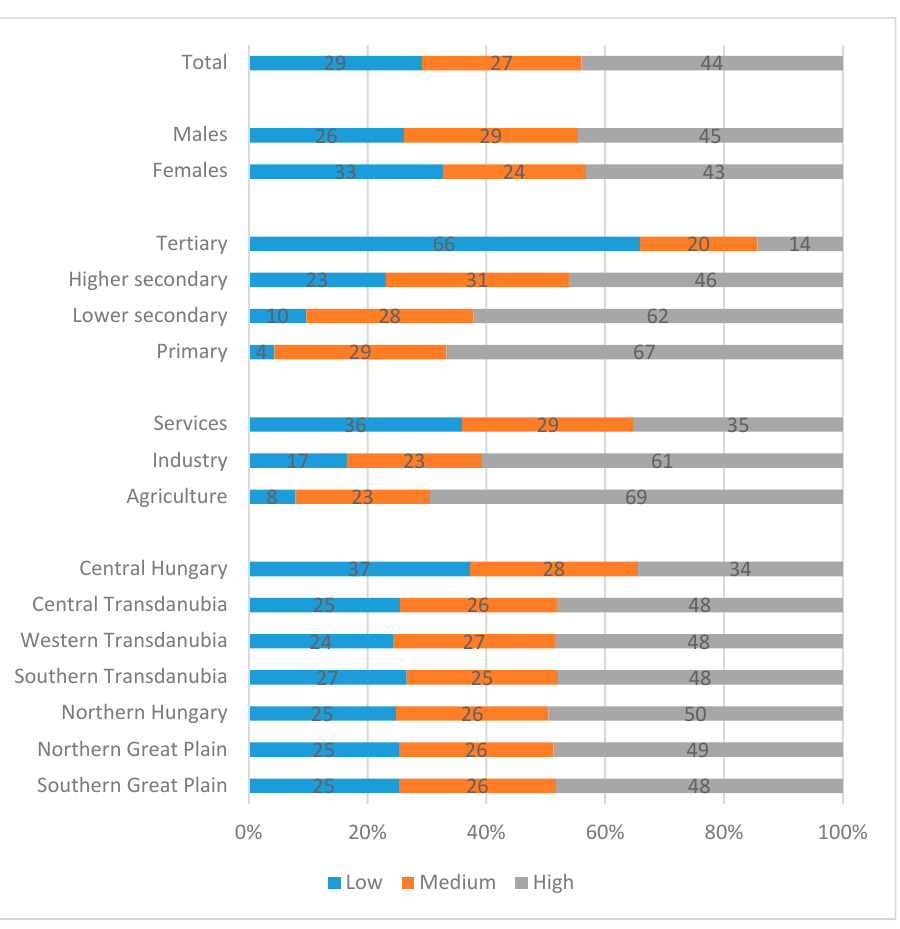
Figure 4. Breakdown of low, medium, and highly susceptible groups to automation by gender, educational attainment, industry, and region in percentage in 2016. Source: Microcensus 2016. Note: According to international examples, those with high susceptibility were considered to be p > 70 and those with low susceptibility were considered to be p < 30.